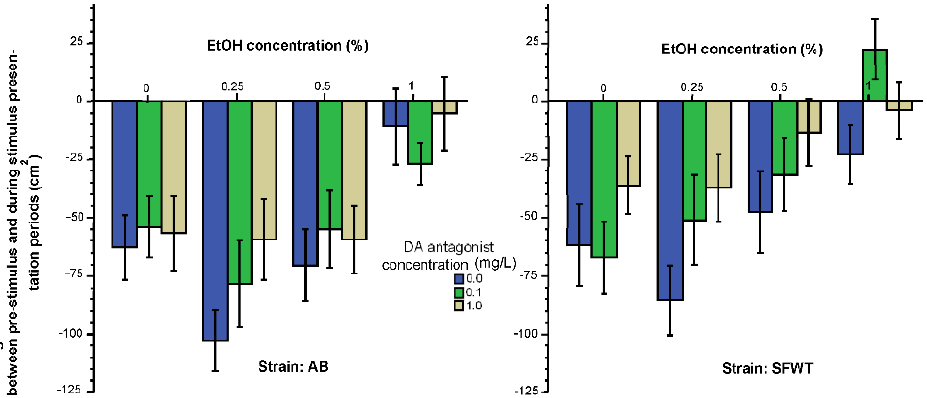
Figure 2. Change of temporal intra-individual variance of distance to stimulus screen (horizontal exploration) elicited by the presentation of animated conspecific images is influenced by the con- centration of acute alcohol (X-axis) and the concentration of acute D1-R antagonist (legend) in an additive manner. Additionally, note the significant strain difference. Mean ± S.E.M. are shown.